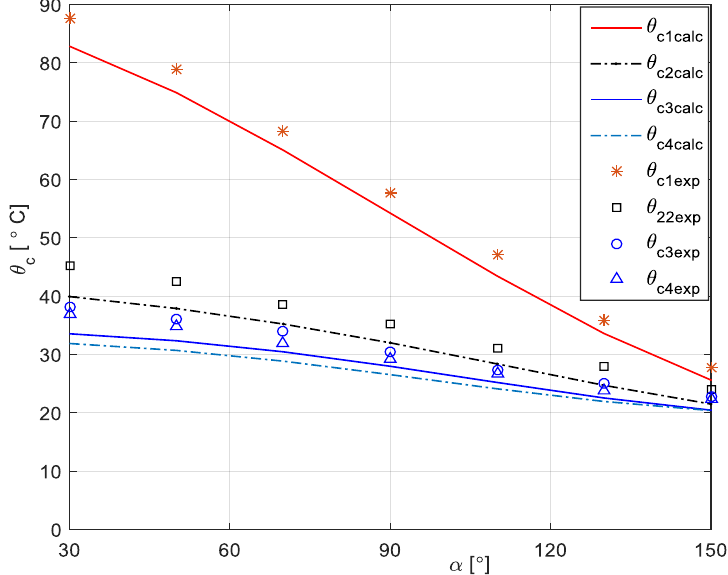
Figure 14. Case temperature variation vs. firing angle at different load resistance values of 1.4, 5, 10, and 16 Ω ( v air = 3 m/s; I = 200 A; L = 30 mH).